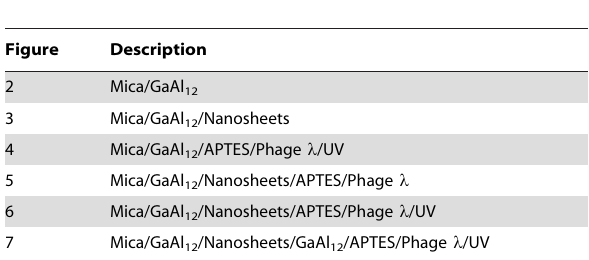
Table 1. The treatments for samples imaged in Figures 2, 3, 4, 5, 6,